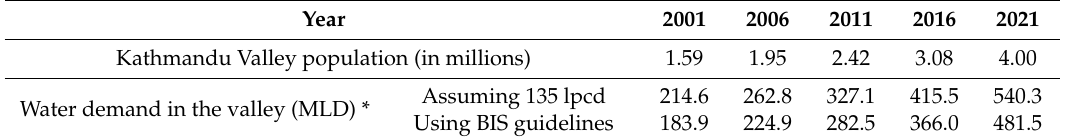
Figure 2. Village Development Committee (VDC)/municipality domestic water demand using Bureau of Indian Standards (BIS) guidelines. Kathmandu Metropolitan City, Lalitpur Sub-metropolitan City, and the Madhyapur Thimi, Bhaktapur, and Kirtipur Municipalities have the highest water demand due to their highly dense populations. Table 1. Estimated water demand in the Kathmandu Valley. The BIS guidelines are based on water use that varies by setting (rural or urban), water supply and sanitation coverage (instead of assuming constant water demand). Water demand over the KUKL service area is expected to rise to 482 MLD by